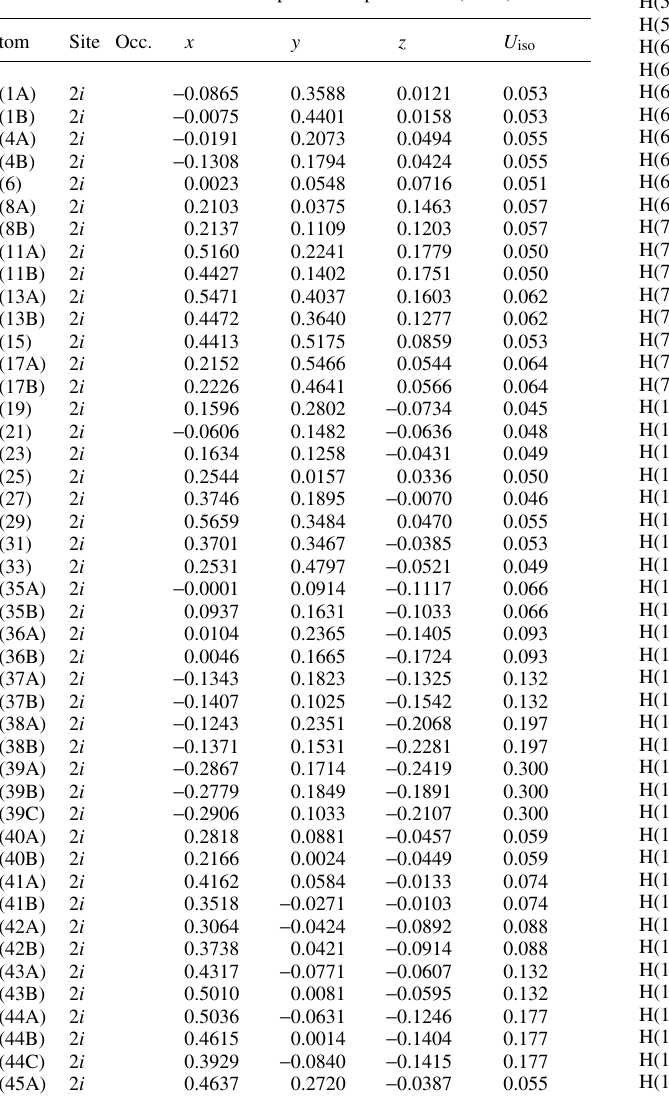
Table 2. Atomic coordinates and displacement parameters (in Å 2 ) .